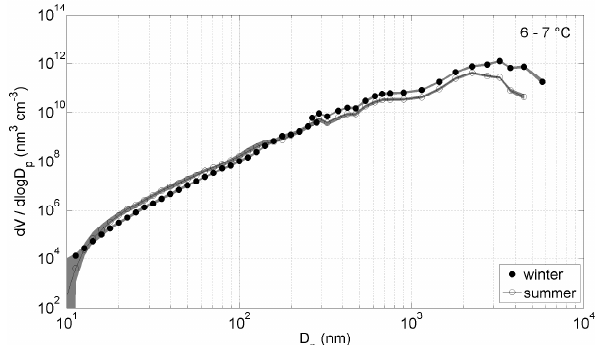
Fig. 9. Comparison of particle volume size distributions resulting from deep sea water during summertime and wintertime, for the same water temperature ranges of 6–7 ◦ C. Grey shaded areas repre- sent the interquartile